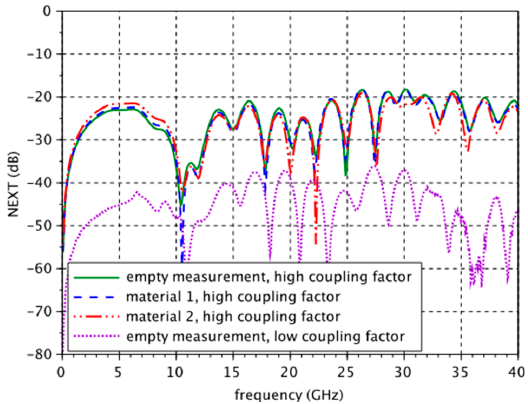
Figure 19. NEXT of coupled microstrip lines without and with two different ACP specimens in comparison to weakly coupled lines without an ACP specimen.